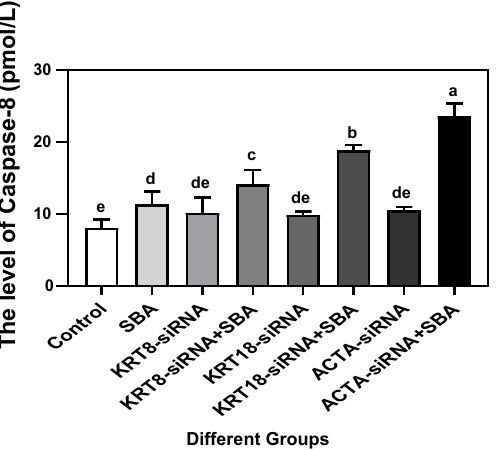
Figure 20. Different treatments induce caspase-8 activations. IPEC-J2 were treated in different treatments (Control treatment (T1); SBA treatment (T9); KRT8-siRNA treatment (T2); KRT8-siRNA + SBA treatment (T10); KRT18-siRNA treatment (T3); KRT18-siRNA + SBA treatment (T11); ACTA-siRNA treatment (T4); and ACTA-siRNA + SBA treatment (T12)) for 24 h. Caspase-8 was determined using the double antibody sandwich method of ELISA. Each column represents the mean ± SEM of three independent experiments. Different lowercase letters indicate the significance of differences between different treatment groups ( p < 0.05).